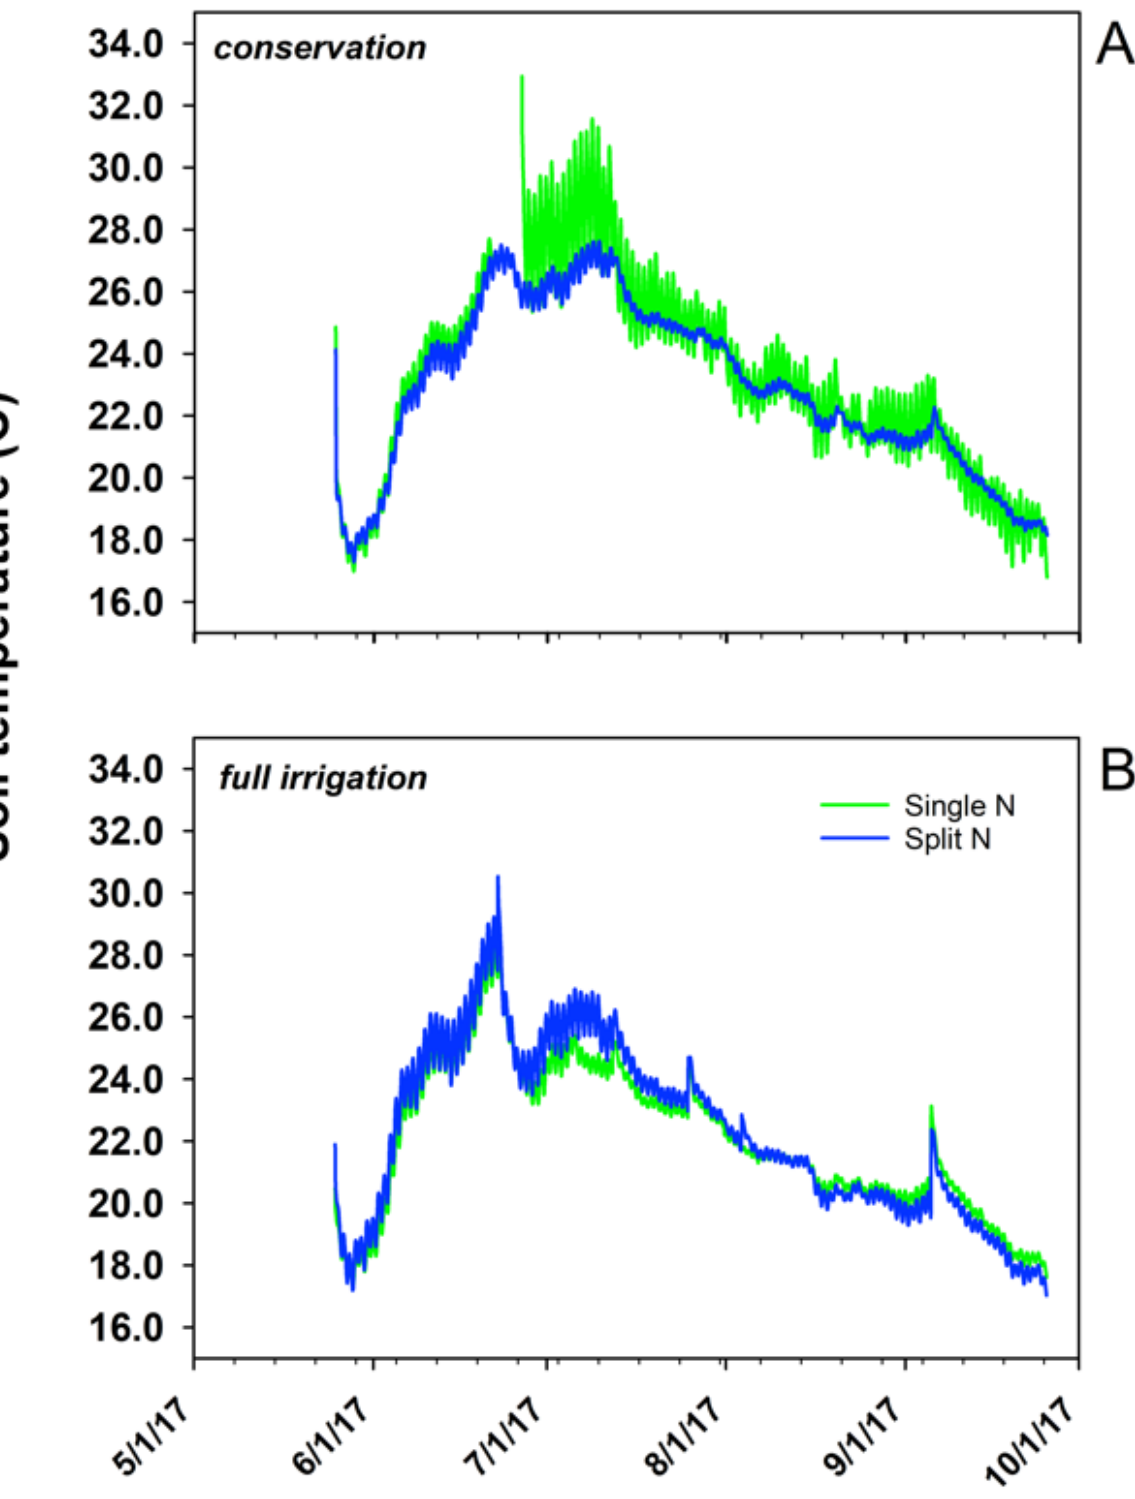
Figure 3. Soil temperature in sorghum fields under ( A ) 30% less irrigation and ( B ) full irrigation. Colored lines indicate fertilizer additions entirely at planting or split between 2 applications.